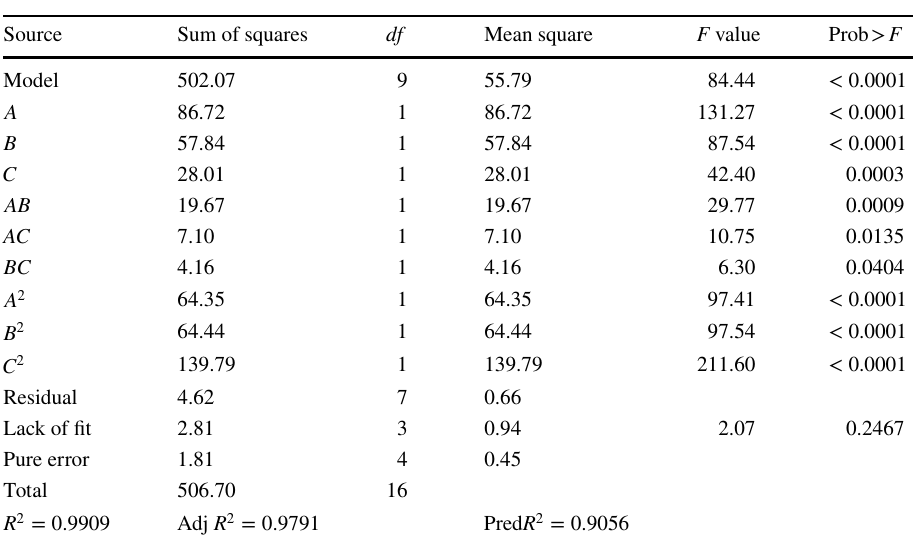
Table 5 Analysis of variance (ANOVA) for the quadratic